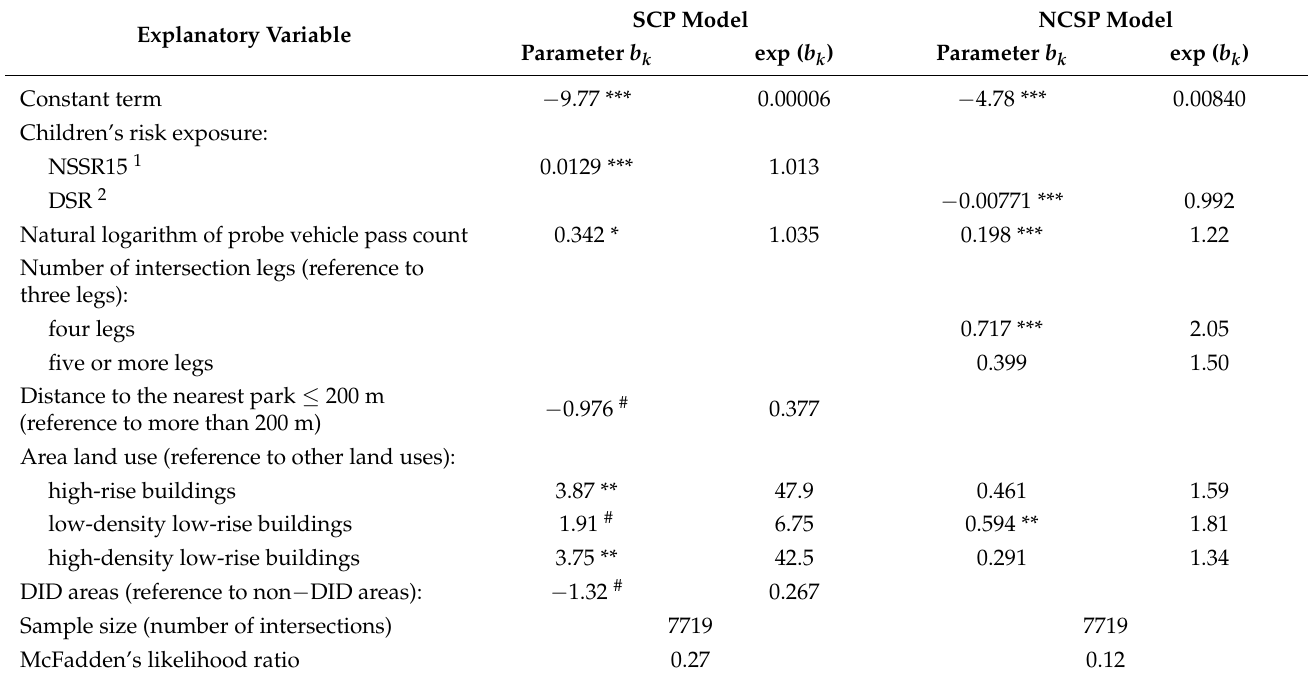
Table 2. Estimation results of the NB regression models for the ESSVAs.